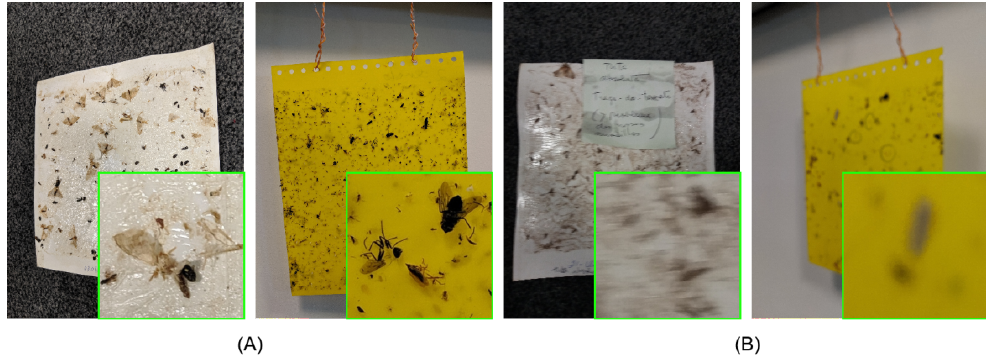
Figure 2. Illustrative images labeled as: ( A ) focused; and ( B ) unfocused.